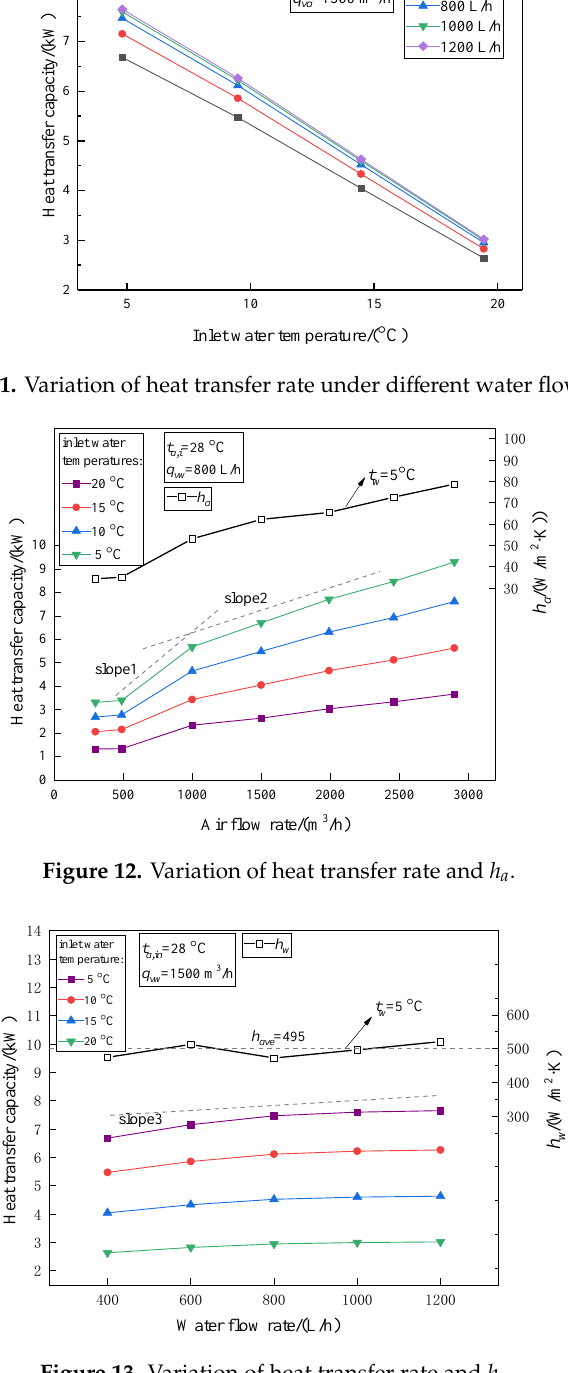
Curve 1 Figure 14. ε -NTU plots and fitting curves under different specific heat capacity ratios. Table 3. Fitting equations of ε -NTU. Curves